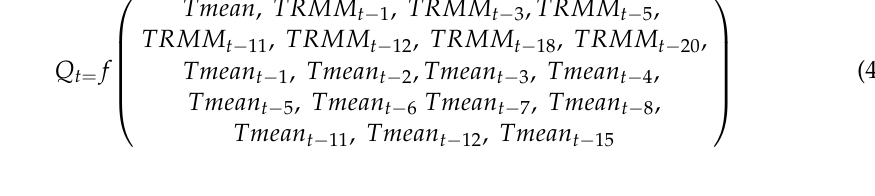
Table 1. Selected parameters of the HEC-HMS model. Snyder Hydrograph Deficit and Constant Standard Lag Peaking Constant Rate Maximum Initial (h) Coefficient (mm/h) * Storage (mm)